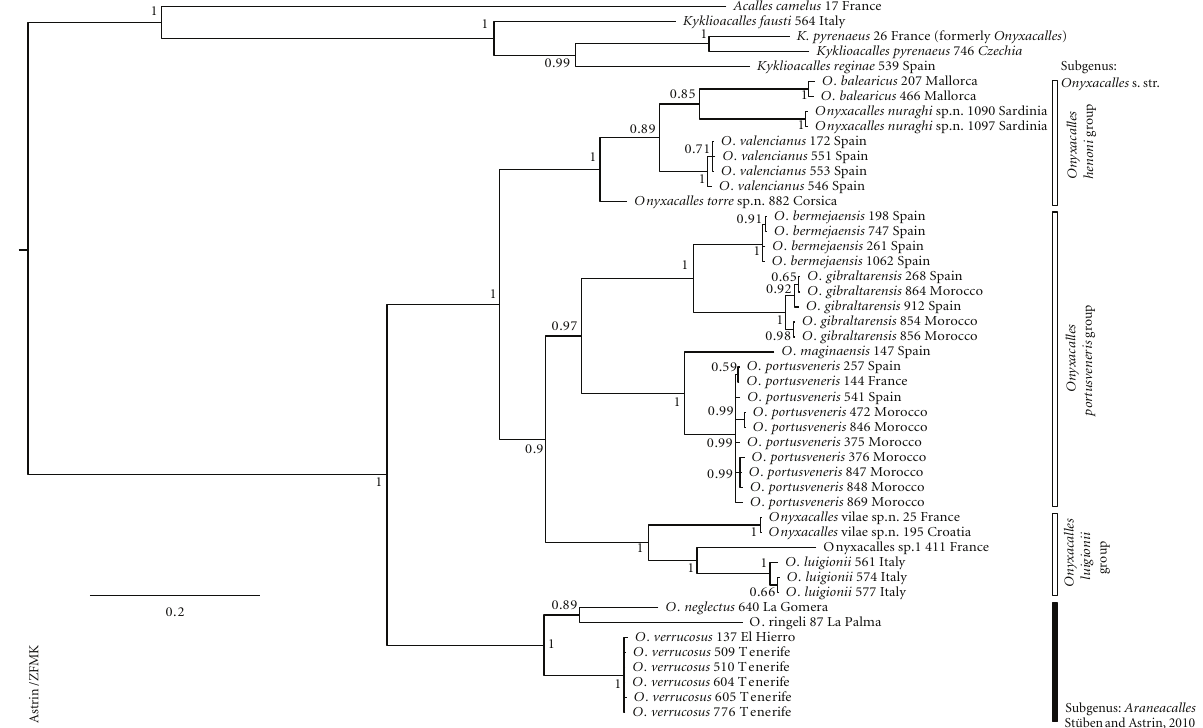
Figure 1: Bayesian consensus tree (50% majority rule) for COI and